Question: Sum up the contents of this chart in one sentence.
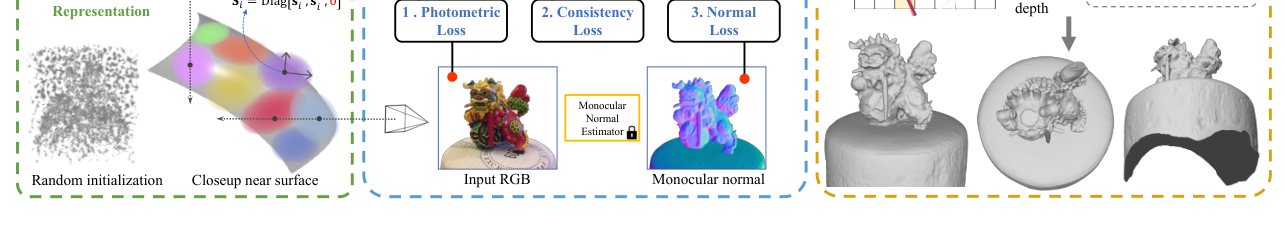
Answer: The pipeline of our method. Our method involves the following steps: (a) Starting with random initialization, our method represents the surface as a set of Gaussian surfels, each with learnable position, rotation, color, opacity, and covariance; (b) Optimize the Gaussian surfels through multi-view photometric loss, depth-normal consistency loss, and normal prior loss; (c) Perform volumetric cutting on rendered depth maps, then apply Poisson meshing from rendered depth and normal to extract a high-quality mesh. Our method can automatically obtain an open surface reconstruction result.